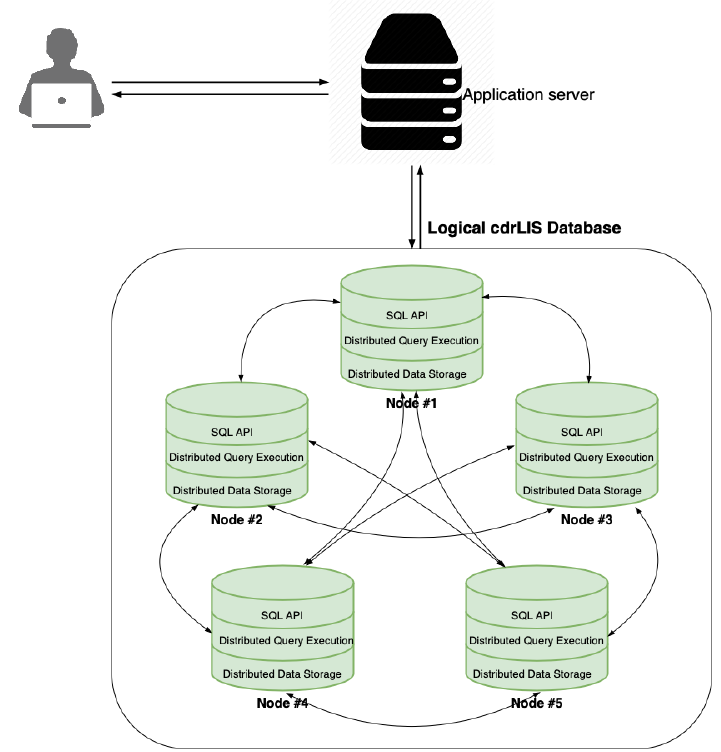
Figure 3. Single-site distributed